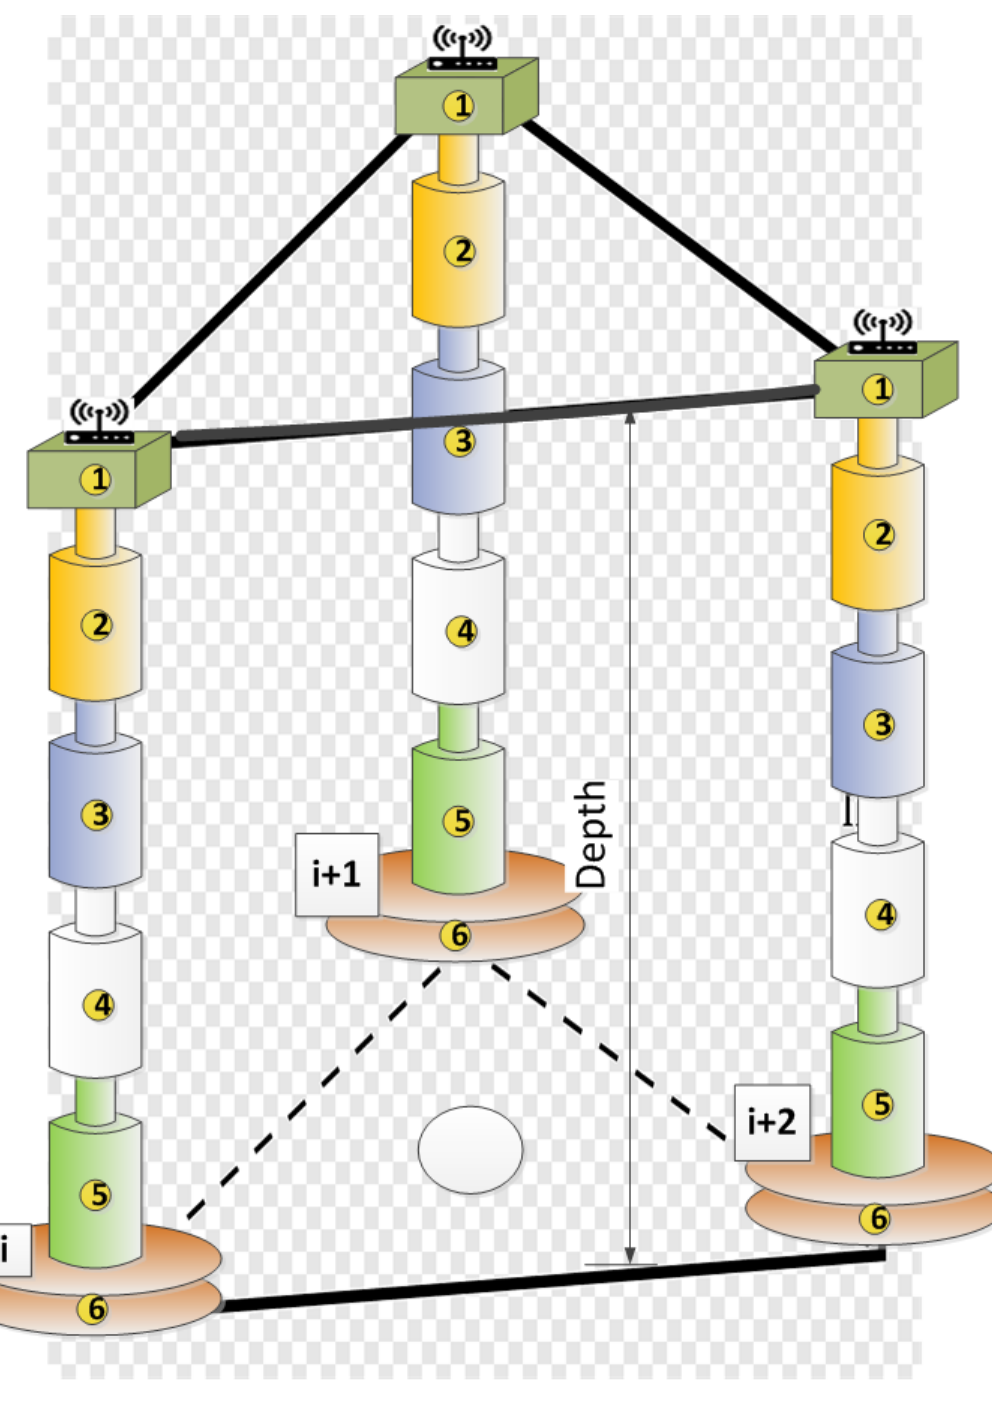
Figure 1. “Prism” of multimodal sensor stations.